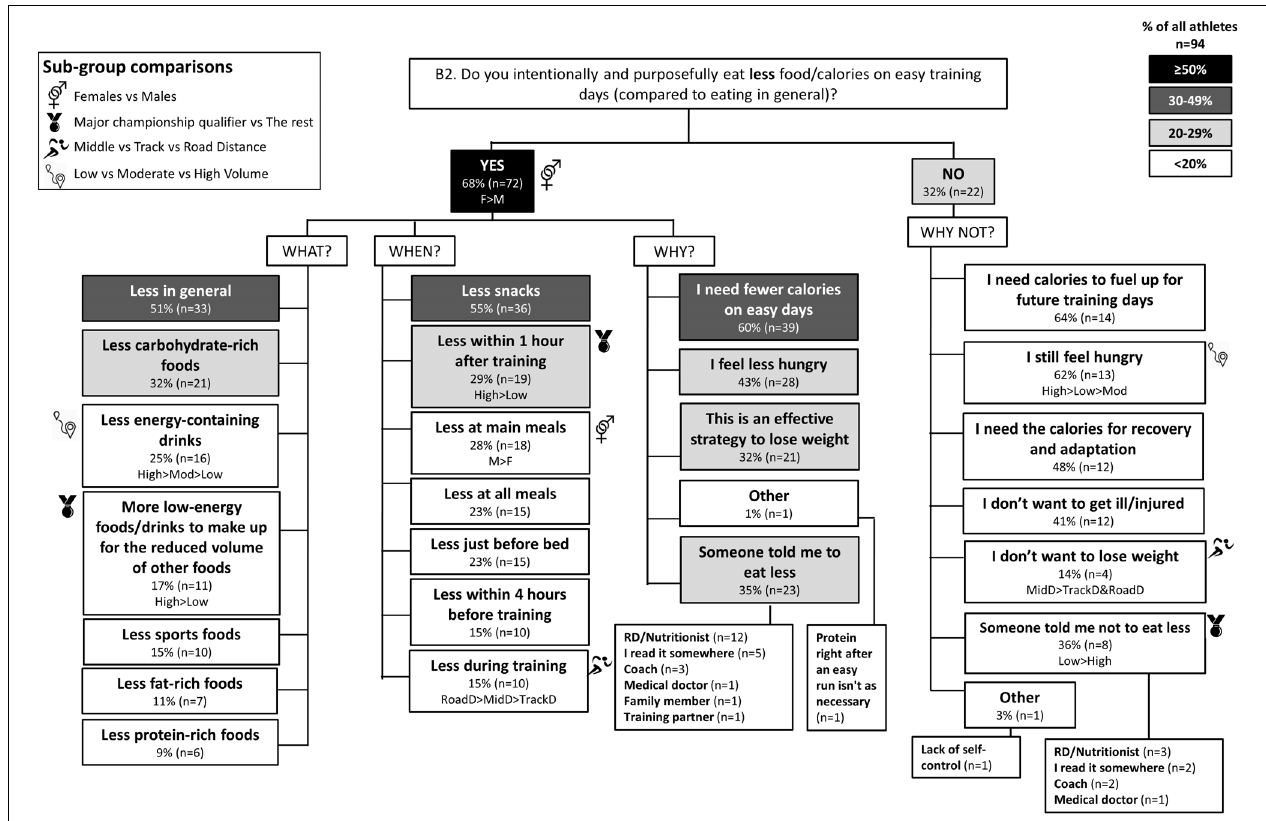
FIGURE 3 | B2: Nutrition on easy training days during base training phase. The prevalence of specific nutrition practices on easy training days and the reasons for following them in 94 elite female and male track and field endurance athletes. Please see full description for figure within Figure 1 .